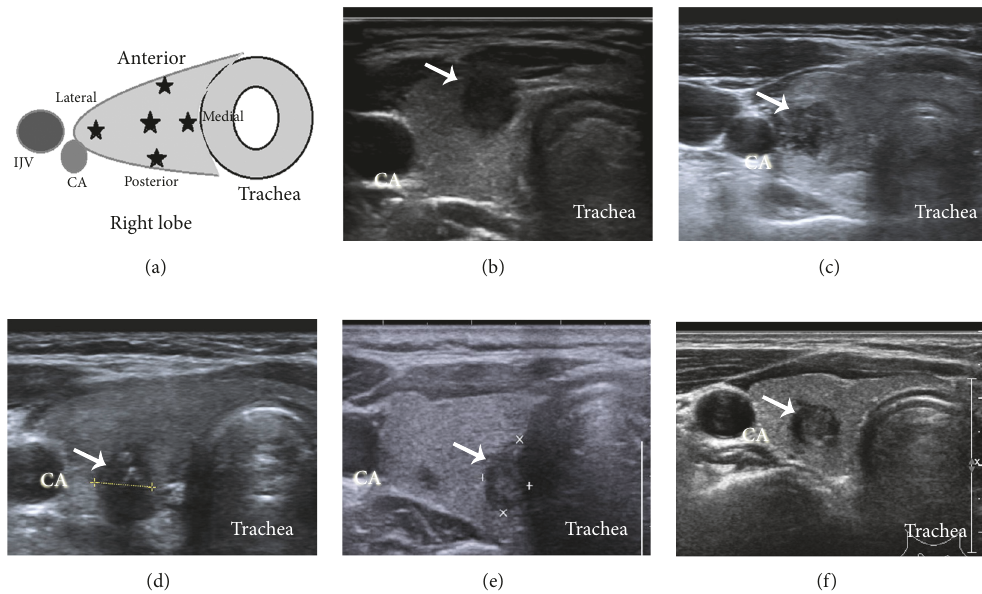
Figure1:(a)Schematicofdifferentlocations(asterisks)ofthyroidmicrocarcinomasinthethyroidlobe.Subcapsularthyroidmicrocarcinomas (arrow) can be located (b) anterior to the strap muscles, (c) lateral to the carotid artery, and (d) posterior or (e) medial to the trachea in the lobe. Nonsubcapsular thyroid microcarcinomas arelocated in themiddleofthelobe at a certain distance fromthethyroid capsule. CA, carotid artery; IJV, internal jugular